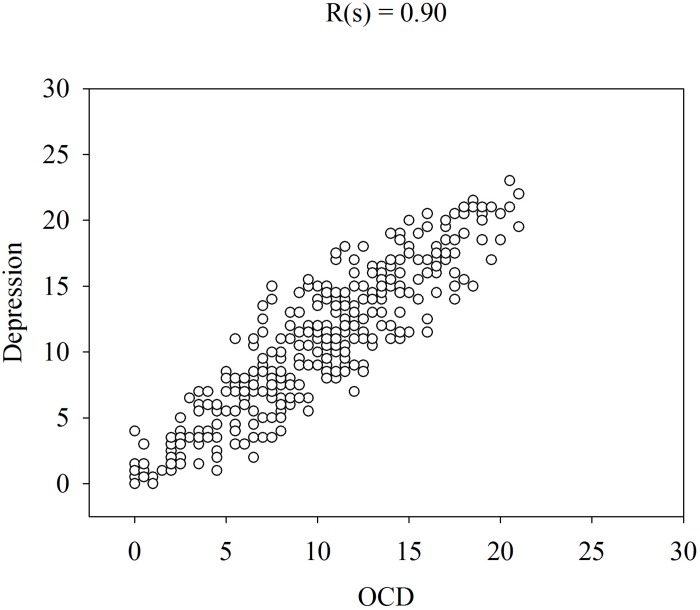
Spearman rank correlation [R(s)] among depression and OCD in 358 patients with anorexia nervosa determined with the CPRS.